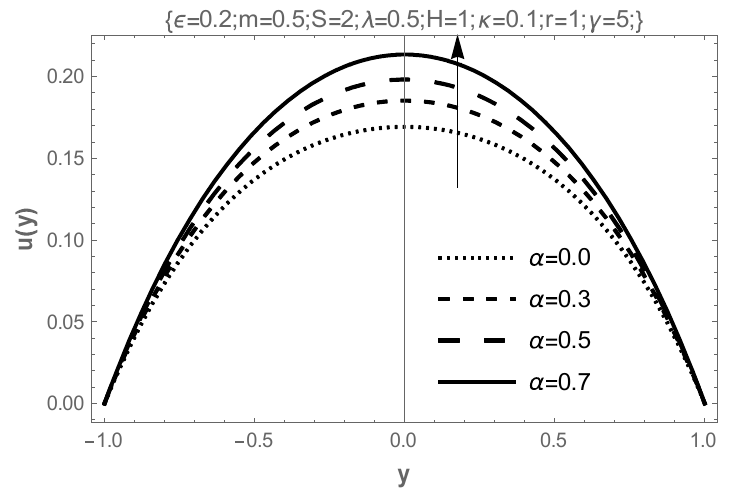
Figure 6. Effect of the porous permeability variation parameter on flow velocity.